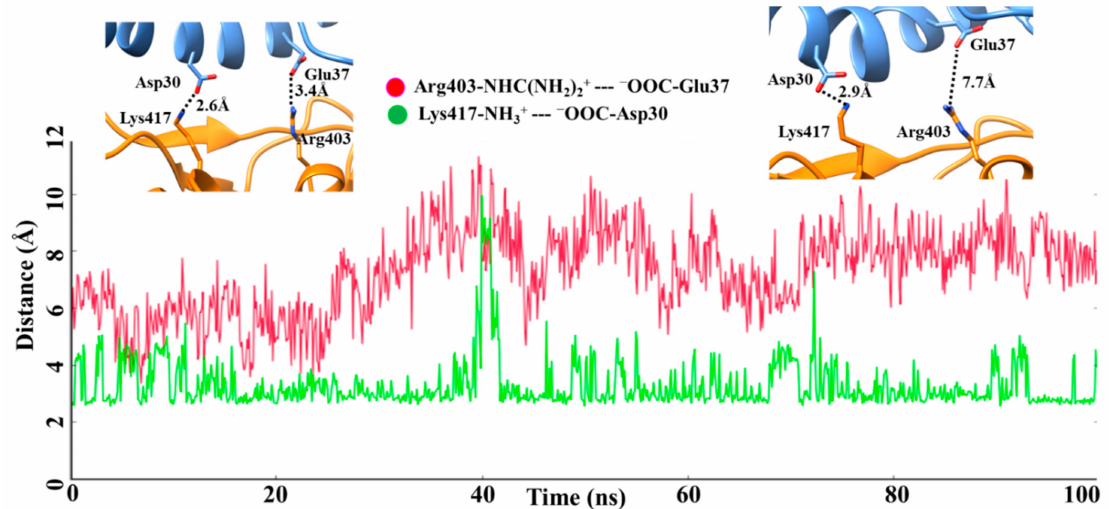
Figure 5. Salt bridges interactions and their corresponding distances between the wild type spike RBD and the hACE2 receptor complex during 100 ns of MD